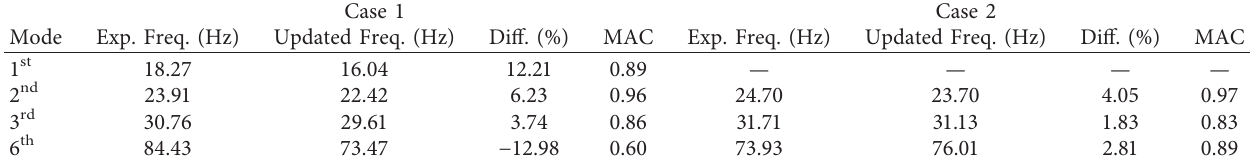
Figure 22: Updating results of the stiffness degradation: (a) Case 1; (b) Case 2. Table 7: Comparison of the identified and tested modal parameters in Case 1 and Case